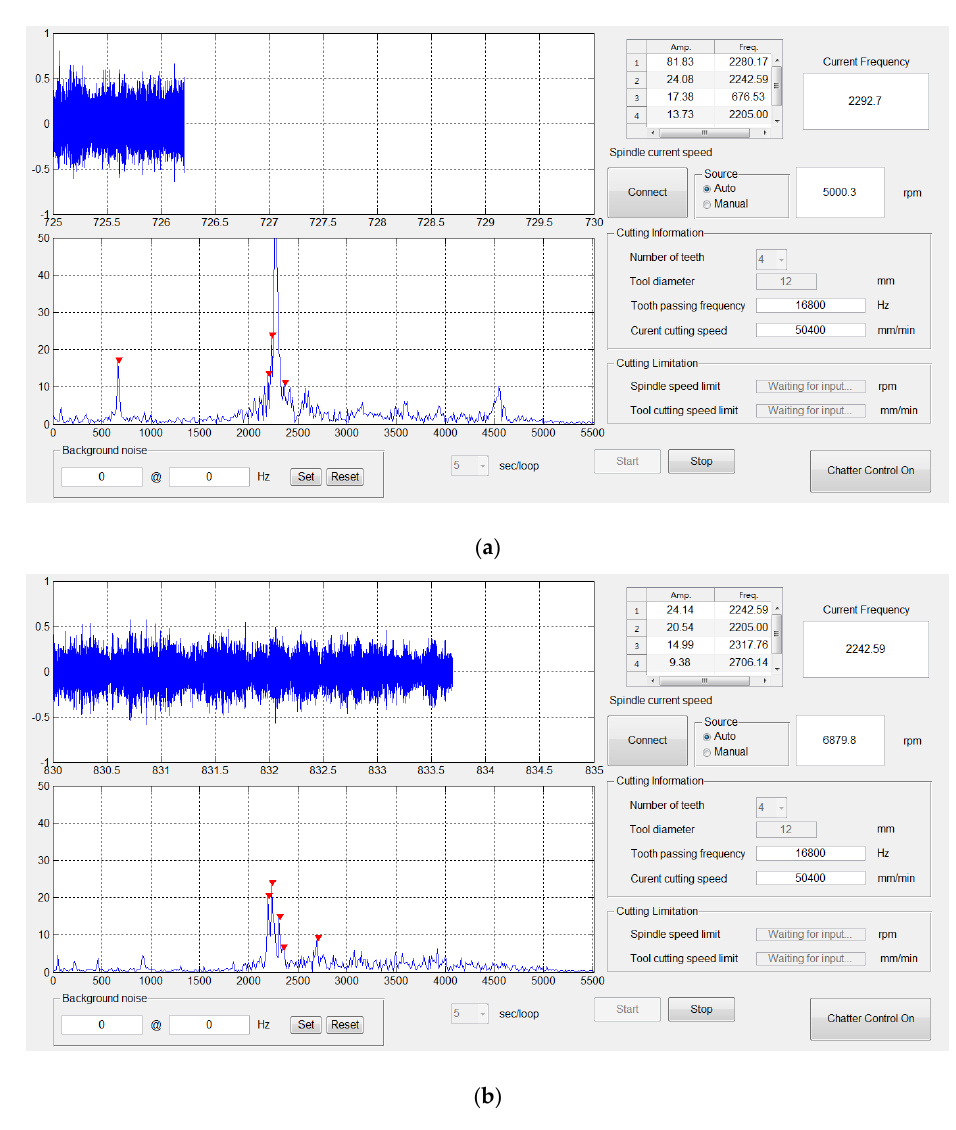
Figure 14. Experimental results displayed in the operation interface of the developed program: ( a ) S = 5000 rpm, ( b ) S = 6879 rpm. ( a ) S = 5000 rpm, ( b ) S = 6879